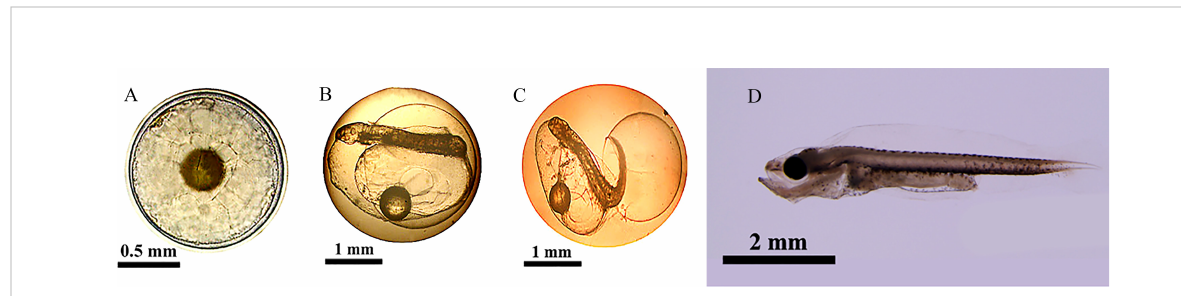
FIGURE 1 Different developmental stages of cobia sampled in this experiment (Kuang et al., 2021) (A) fertilized eggs, (B) embryonic stage, (C) newly- hatched larvae stage, (D) open-mouthed larvae stage. Fertilized eggs: The fertilized egg was round, colorless, and translucent, with one oil ball, small periegg space, egg diameter of 1.2 mm, and oil ball diameter of 0.3mm. The fertilized egg fl oated on the water surface. It presented the state that the animal pole faced down and the plant pole faced up due to a large oil ball at the plant pole. Embryonic stage: 24 hours after fertilization, the embryo body coiled in the egg membrane and circled around the yolk, and the caudal fi n differentiation was apparent. The heart beats continuously, with a frequency of about 185 times/min, and blood fl ow can be observed. The tail twisted violently, causing the embryo body to rotate frequently in the egg membrane. At 25 h and 30 min after fertilization, the egg membrane near the head gradually bulged with the strengthening of the swing of the tail of the embryo. Newly-hatched larvae stage: The total length was 2.0 mm, about 26 hours after fertilization; under the violent swing of the tail, the larvae were basically separated from the egg membrane, and the process of membrane emergence lasted for about 30 minutes. Open-mouthed larvae stage: The total length was 4.4mm, the length diameter of the yolk-sac was 0.3mm, and the diameter of the oil ball was 0.2mm. The intestinal peristalsis was intensi fi ed, the mouth cleft was frequently opened and closed, the eye sac was black, the pectoral fi n was enlarged, which can be freely condensed and opened, and the back of the anal fi n membrane had a brown pigment